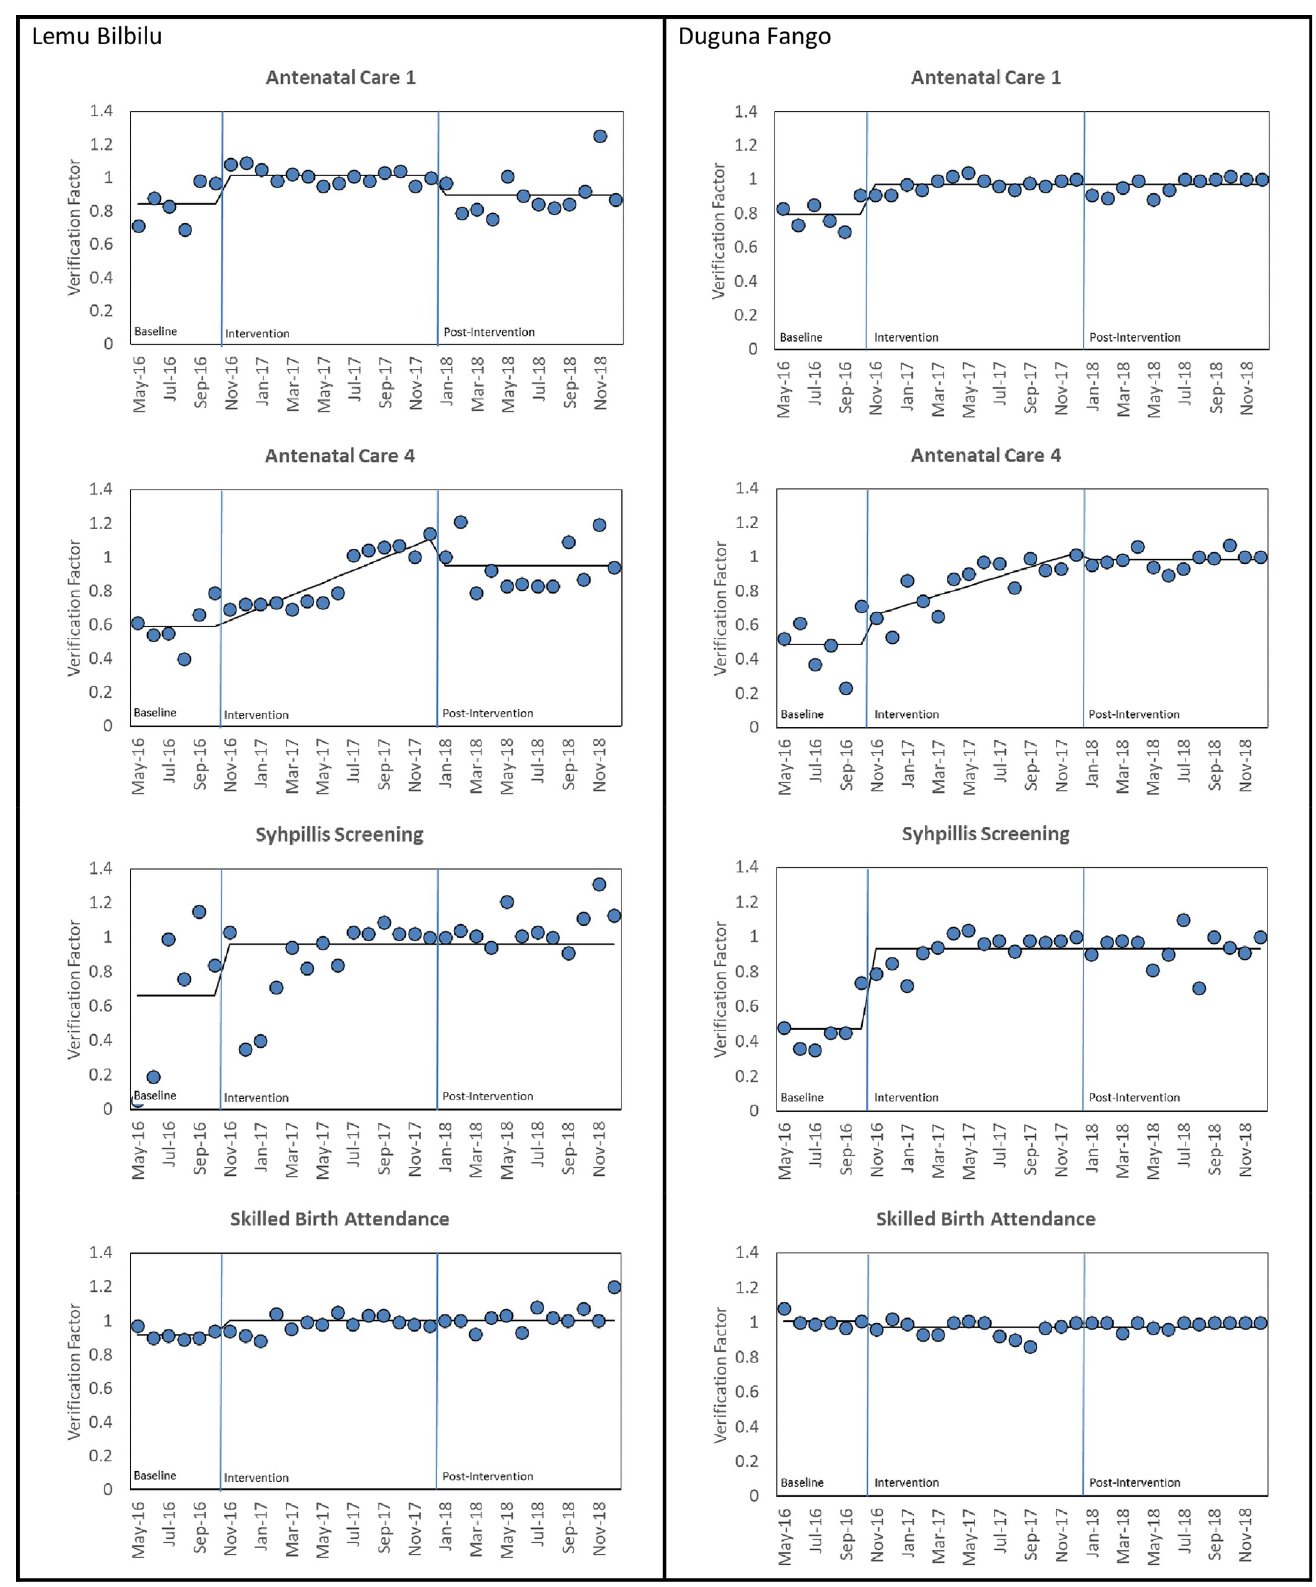
Fig 2. Interrupted time series graph of change in verification factor from baseline to post-intervention. https://doi.org/10.1371/journal.pone.0237703.g002 PLOS ONE | https://doi.org/10.1371/journal.pone.0237703 August 14,